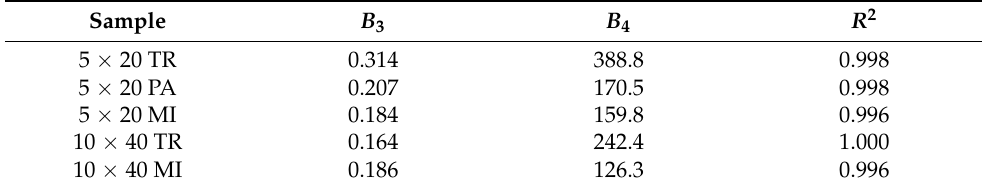
Table 4. The values of coefficients B 3 , B 4 and R 2 from Equation (14) obtained for individual samples. Sample